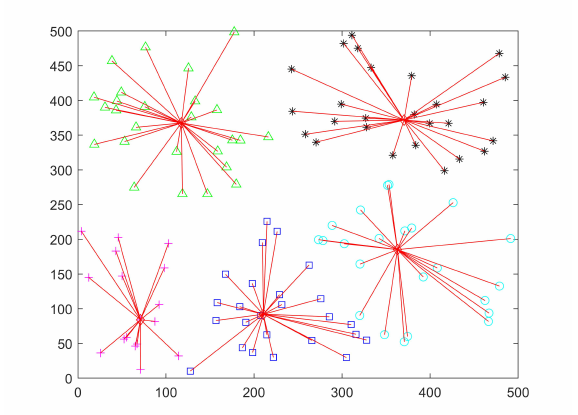
Figure 2. Sensor association result of the proposed algorithm.